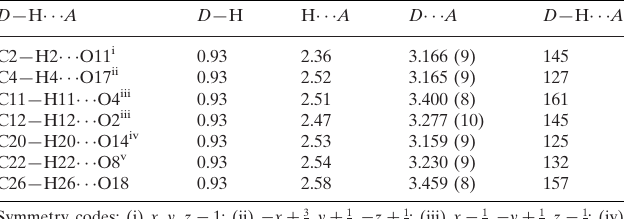
Hydrogen-bond geometry (A˚ , (cid:3)